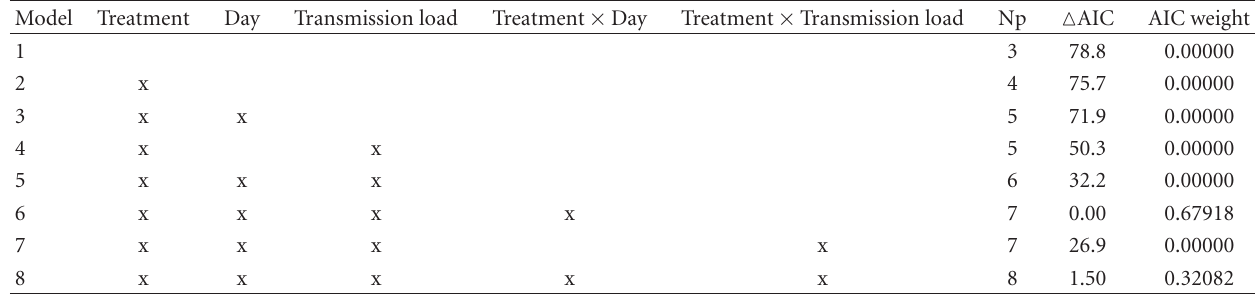
Table 9: Results from model selection on space use (proportion use of lower half of enclosure) among domestic tame animals using the AIC criterion (Np is number of